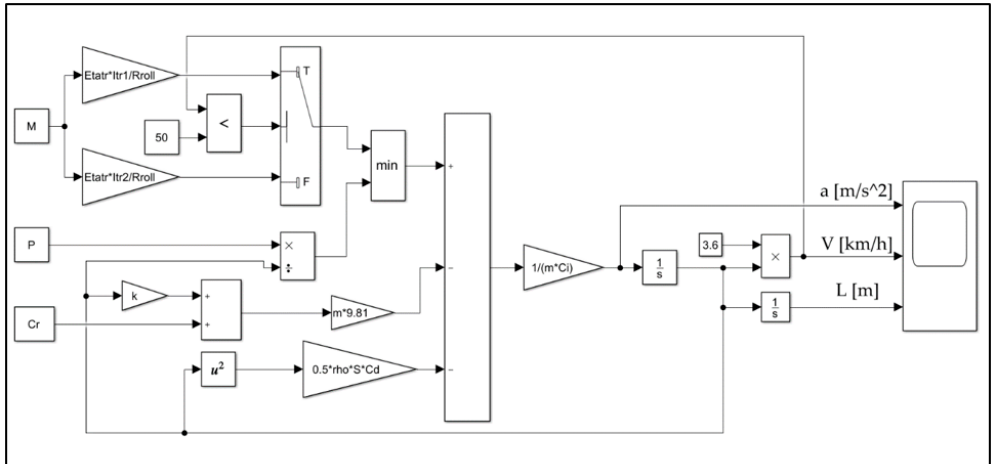
Figure 3. Block scheme of simulation model.